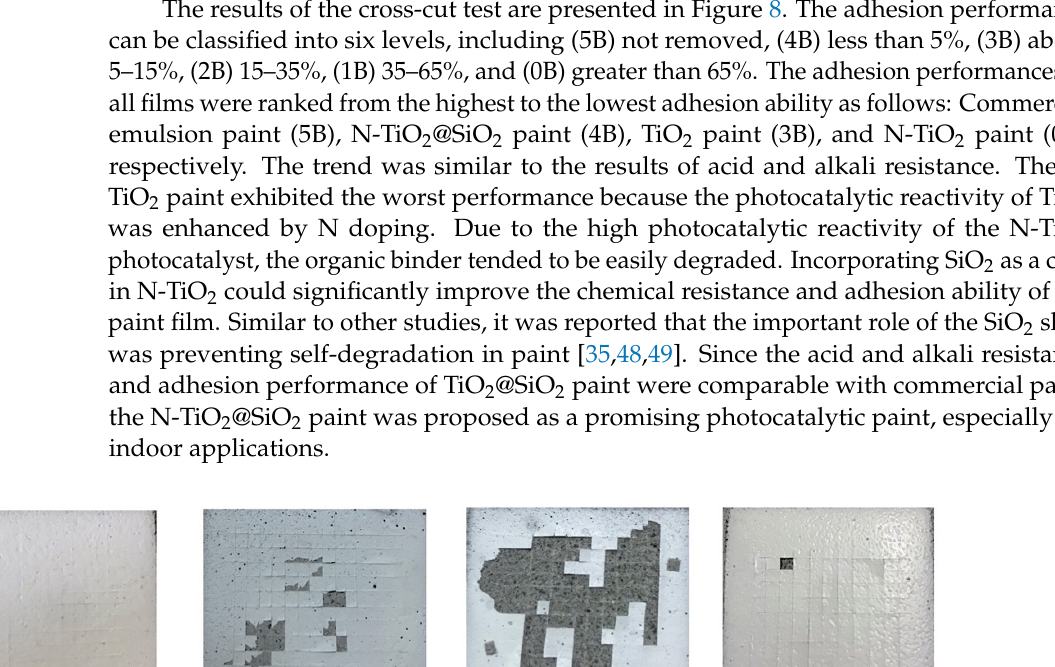
Figure 7. The alkali resistance tests of commercial paint (without photocatalyst), TiO 2 paint, N-TiO 2 paint, and N-TiO 2 @SiO 2 paint.